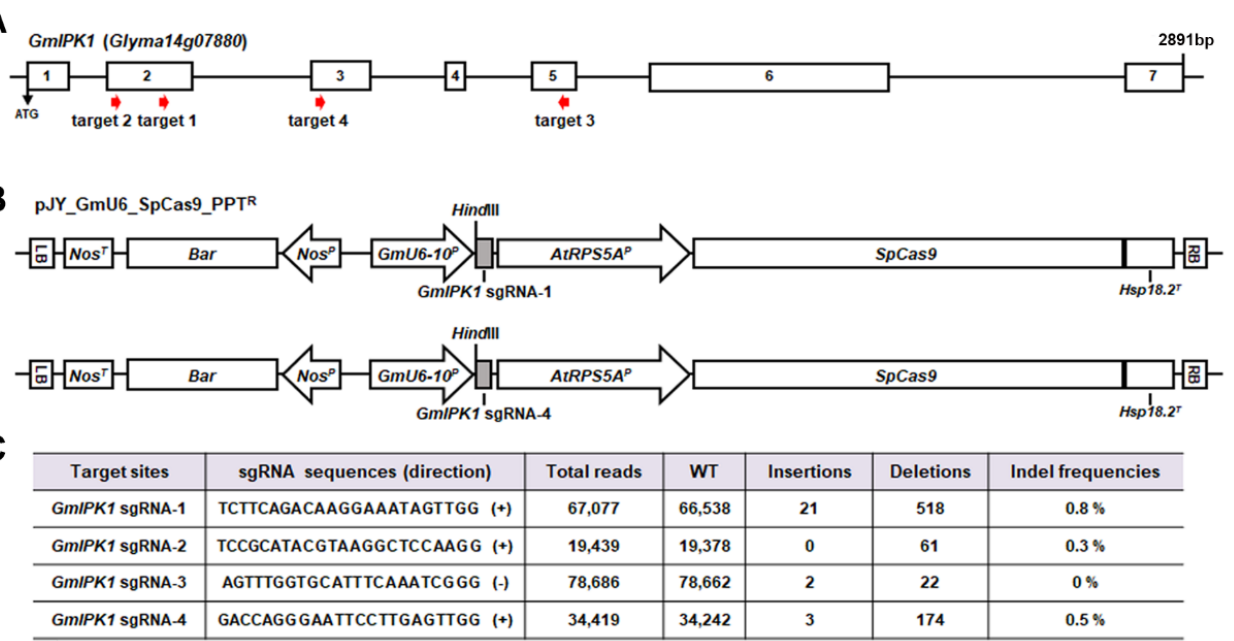
Figure 2. CRISPR/Cas9-targeted mutagenesis of GmIPK1 in soybean protoplasts. ( A ) Schematic diagram of GmIPK1 gene structure and four guide RNA target sites used in this study (red arrows). Based on a comparison with GmIPK1 cDNA, the coding regions (4158 bp) of the GmIPK1 gene are divided into seven exons interrupted by six introns. ( B ) The vector pJY_GmU6-10_SpCas9_ Bar was used for CRISPR/Cas9-mediated soybean gene editing with guide RNAs: AtRPS5A P , Arabidopsis AtRPS5A promotor; GmU6-10 P , soybean U6-10 promotor; sgRNA, single guide RNA; Nos P , nopaline synthase promoter; Nos T , nopaline synthase terminator; SpCas9 , human codon-optimized S. pyogenes Cas9 ; NLS, nuclear location signal; Bar , selective marker gene. ( C ) Four sgRNA sequences of GmIPK1 are shown. Mutation rates tested in soybean protoplasts were determined by indel frequencies (%) through deep sequencing at target regions of the GmIPK1 gene.